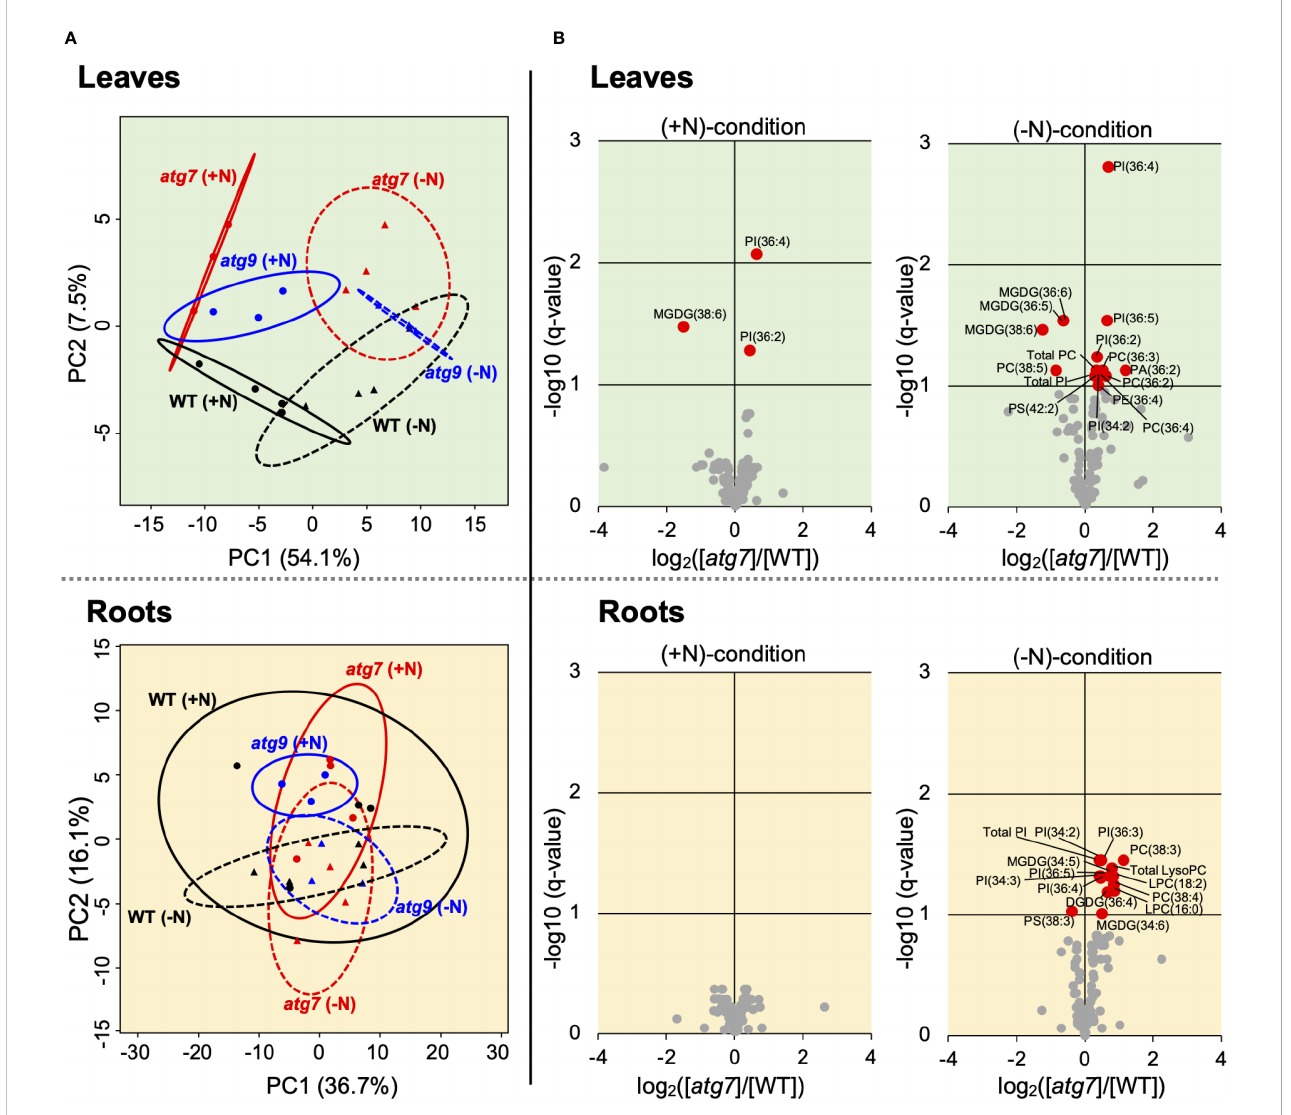
FIGURE 4 Changes in the leaf and root lipidomes induced by the atg7 or atg9 mutations and modi fi ed by (-N) treatment. PCA analysis of lipidomics data obtained from leaves and roots of WT (n=4), atg7 (n=4) and atg9 (n=3) mutant plants grown in either (+N) or (-N) conditions. The 95% con fi dence ellipses of each treatment are indicated (A) . Volcano plot visualization of the differences in the leaf and root lipidomes between WT and atg7 -mutant grown in (+N) or (-N) conditions. q-values were obtained from p-values, which were based on the Wald test (n = 4). Red-colored datapoints represent statistically signi fi cant difference in accumulation of speci fi c lipids (B) . Parallel volcano plots of the atg9 mutant data are presented in Supplemental Figure